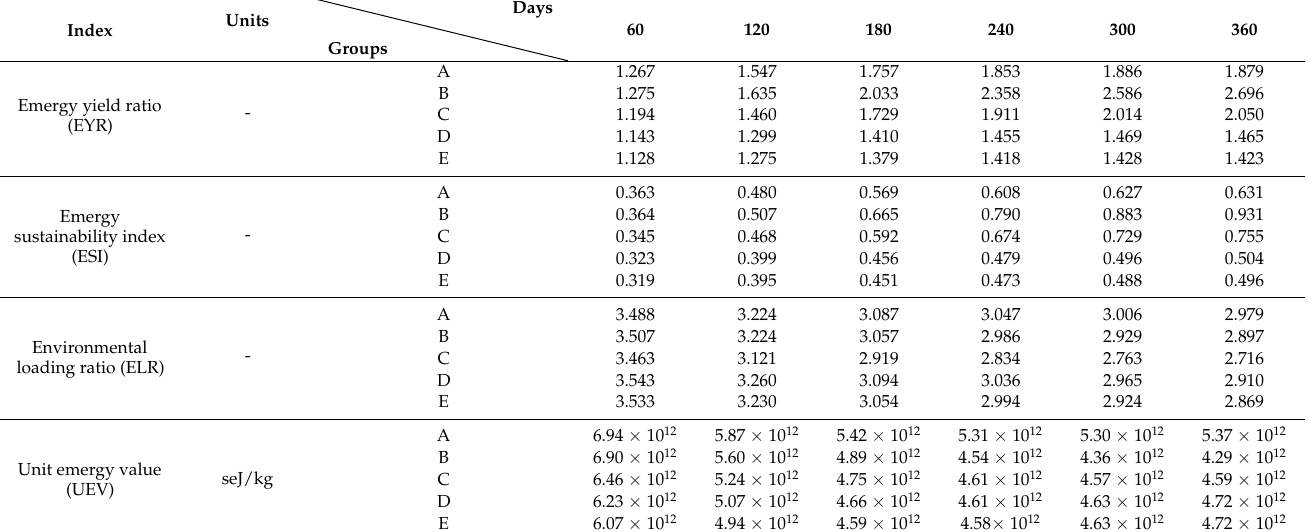
Table 5. Main emergy indices of